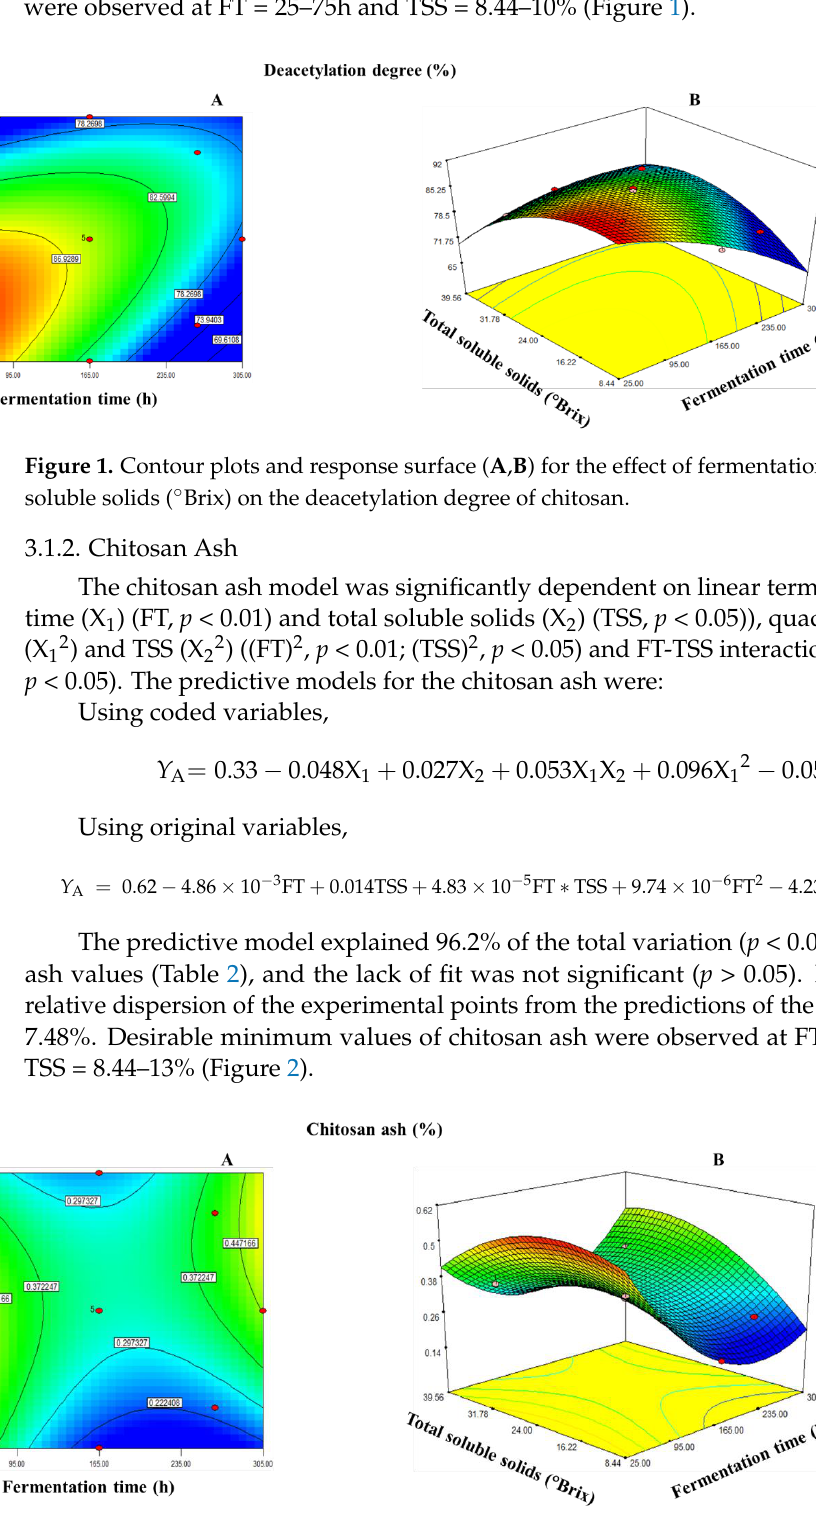
Figure 2. Contour plots and response surface ( A , B ) for the effect of fermentation time (h) and total soluble solids (°Brix) on chitosan ash content.